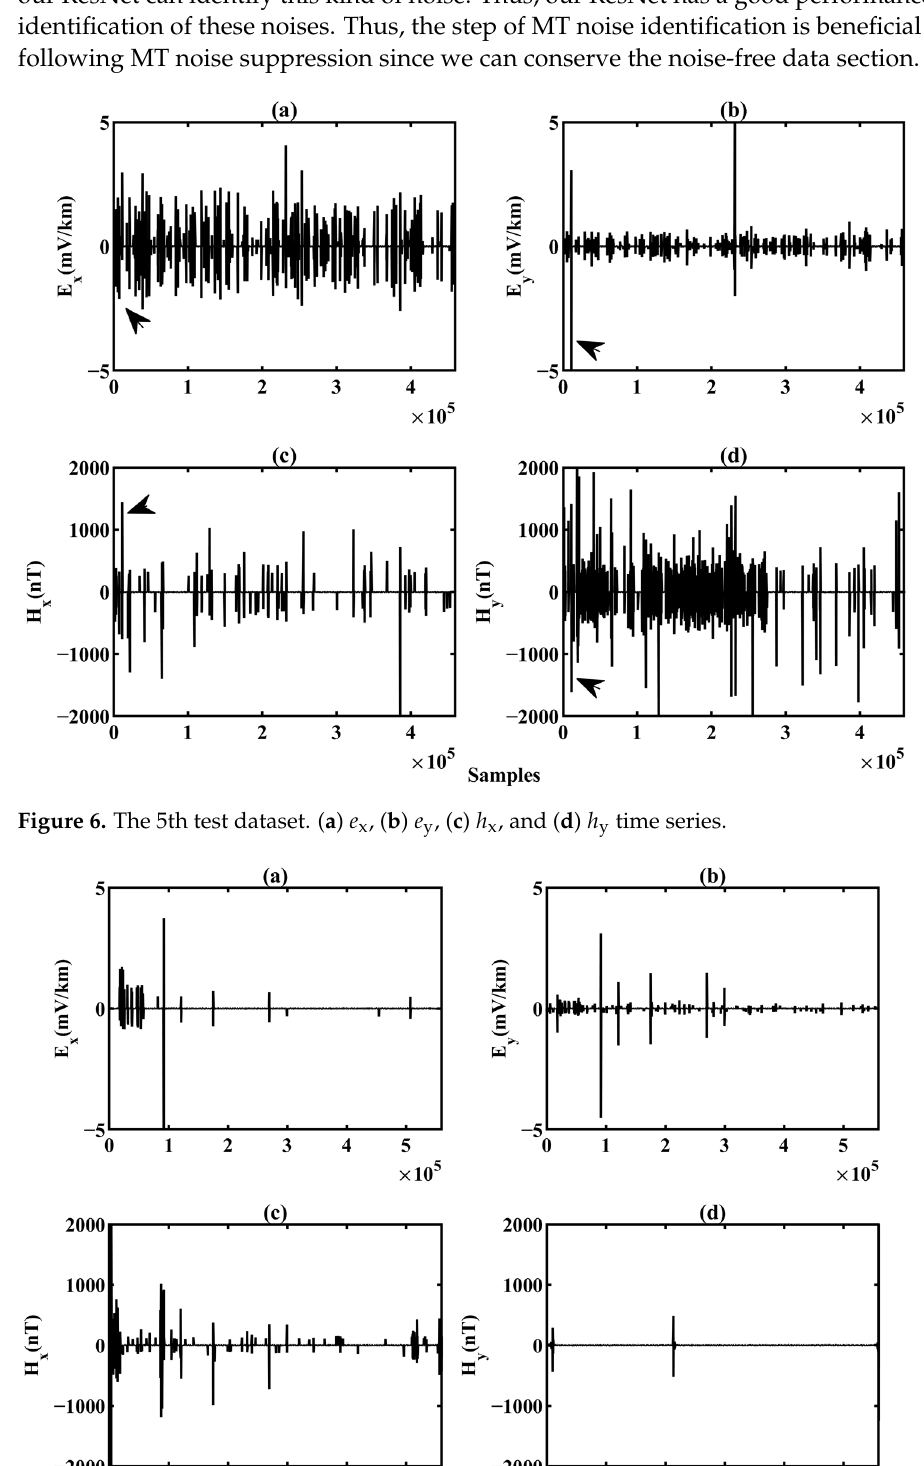
Figure 7. The 12th test dataset. ( a ) e x , ( b ) e y , ( c ) h x , and ( d ) h y time